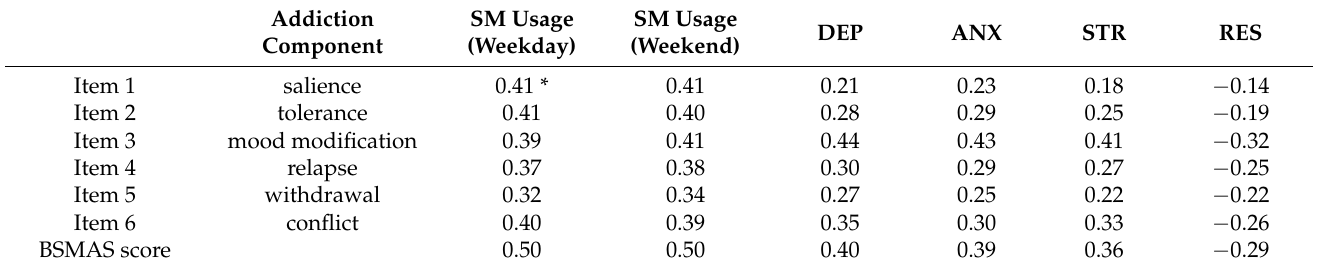
Table 5. Correlation coefficients (Spearman’s ρ ) between BSMAS score and key criterion variables.